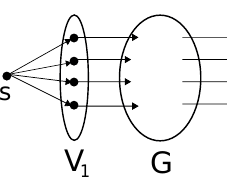
Figure 4. On the ( left ), we have the querying strategy to find all ending vertices corresponding to pattern matches. On the ( right ), we reverse the edges in G to form G R . The graph G R can be used to find starting vertices that correspond to the starting indices of pattern